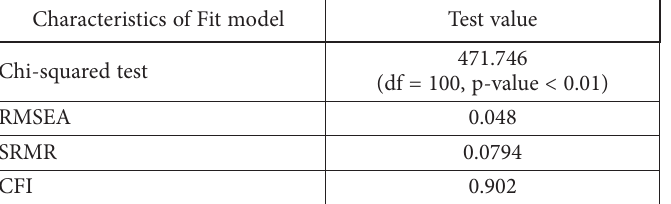
Table 3. Results of the characteristics of Fit model source: own